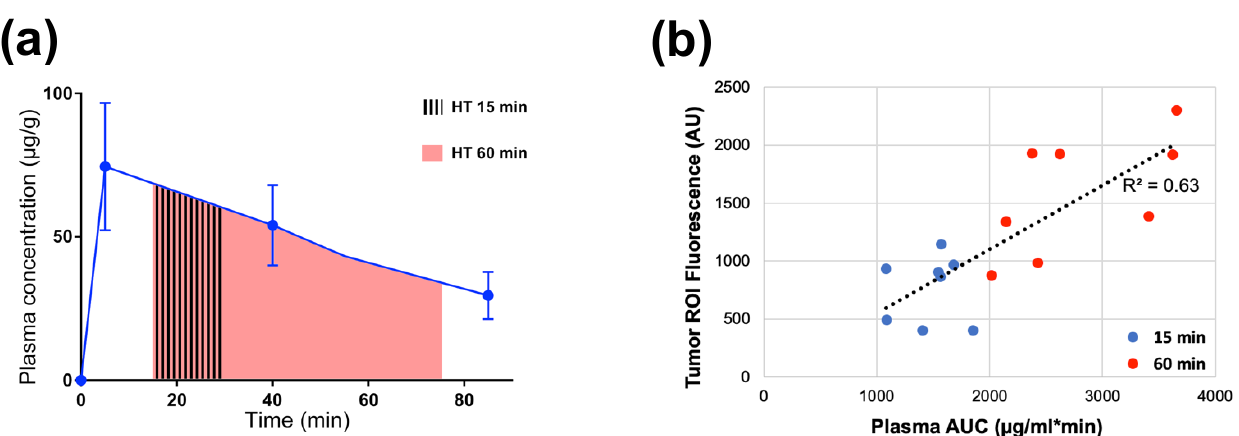
Figure 9. Plasma-AUC during hyperthermia correlates with tumor drug uptake. ( a ) AUC of plasma Dox concentration was calculated during heating, for either 15 or 60 min hyperthermia (HT) as indicated by shaded regions. ( b ) Plasma-AUC during HT correlated well with Dox fluorescence in the tumor region-of-interest measured following HT (R 2 = 0.63). Tumors were exposed to hyperthermia (43 ◦ C) for either 15 min (blue dots) or 60 min (red dots). Data reproduced from [162] (published under CC BY 4.0